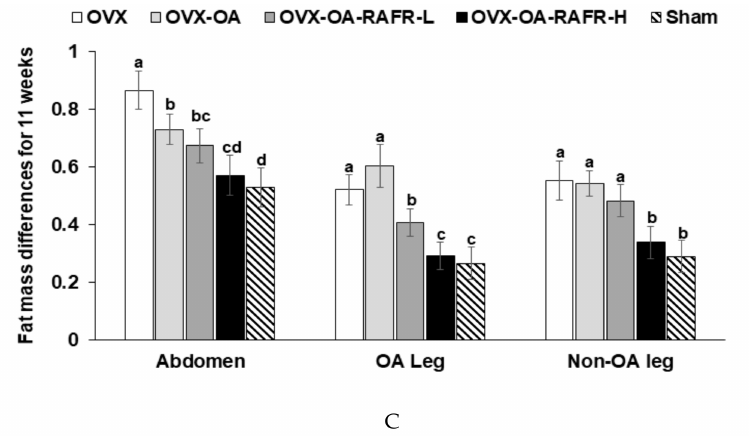
Figure 3. Bone mineral density (BMD) and the lean mass of the femur and knee with the intra-articular injection of monoiodoacetate (MIA) at days 0 and 21 after MIA-injection Ovariectomized (OVX) rats were divided into four groups: (1) MIA injection into the knee joint and fed a high-fat diet containing 0.23% rice + 0.018% AFR diet (RAFR-L). (2) MIA injection into the knee joint and fed a high-fat diet containing 0.69% rice + 0.053% AFR diet (RAFR-H). (3) MIA injection into the knee joint and fed a high-fat diet containing 0.053% cellulose (OA-control). (4) saline injection into the knee joint and fed a high-fat diet containing 0.053% cellulose (non-OA control). Sham rats had the same diet as the control and received a saline injection (normal-control). At the beginning of the eighth week, an articular injection of monoiodoacetate into the right knee was performed in all OVX groups, except the normal-control group, and the assigned diets were provided for an additional three weeks. The BMD ( A ) and lean body mass ( B ) of the hips and right legs, as well as the mass of the fat in the abdomens and right legs ( C ), were measured via DEXA. Each bar and error bar represents the mean ± SD ( n = 10). a,b,c,d Values of the bars with di ff erent superscripts were significantly di ff erent among groups as per the Tukey test at p <